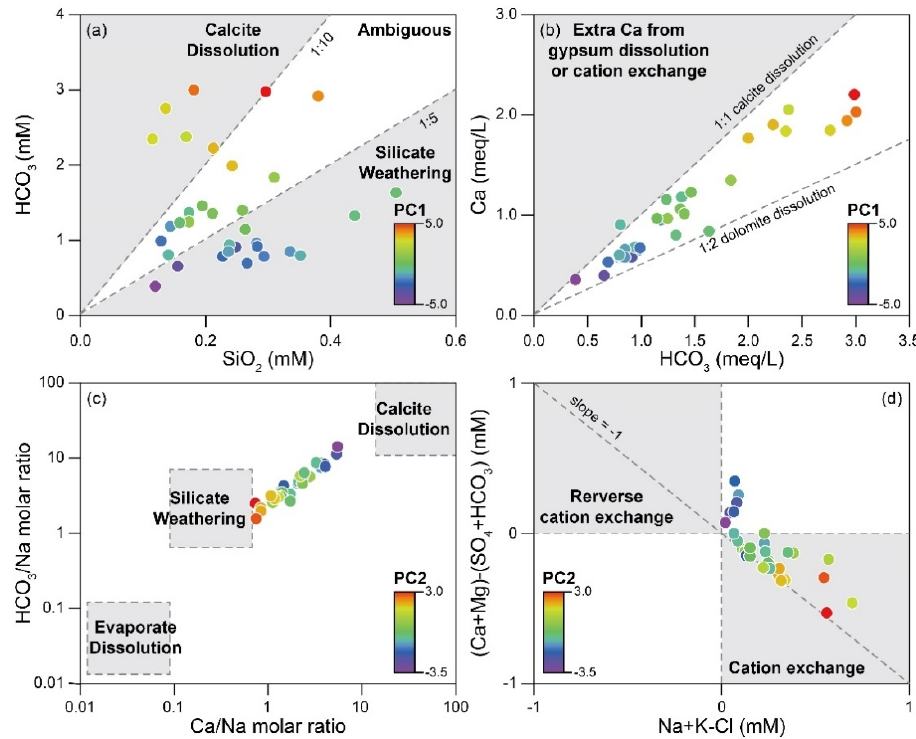
Figure 4. Assessment of natural processes (i.e., mineral dissolution and cation exchange) influencing hydrogeochemical characteristics of Ca-HCO 3 -type bottled water in South Korea ( n = 33), showing ( a ) SiO 2 versus HCO 3 concentrations (in mM), ( b ) HCO 3 versus Ca concentrations (in meq/L), ( c ) Ca/Na versus HCO 3 /Na molar ratios, and (d) Na + K—Cl versus (Ca + Mg)—(SO 4 + HCO 3 ) (in mM). Data points are colored with PC1 scores in ( a ) and ( b ) and PC2 scores in ( c ) and ( d ).